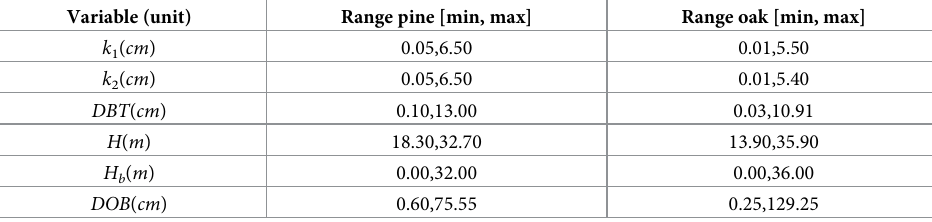
Table 1. Characteristics of the data. k 1 ( cm )—bark thickness at height H b , k 2 ( cm )—bark thickness at height H b , DBT ( cm )—double bark thickness at height H bole from the ground, DOB ( cm )—stemdiameter outside bark at height H b